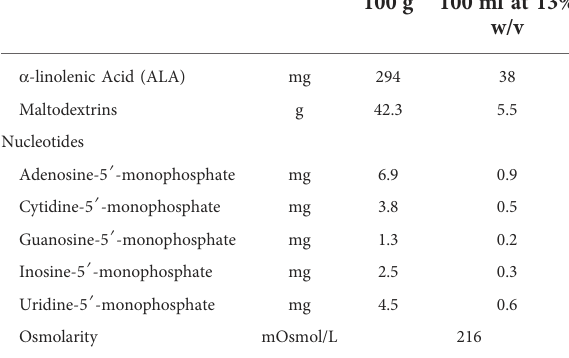
TABLE 1 Composition of the study